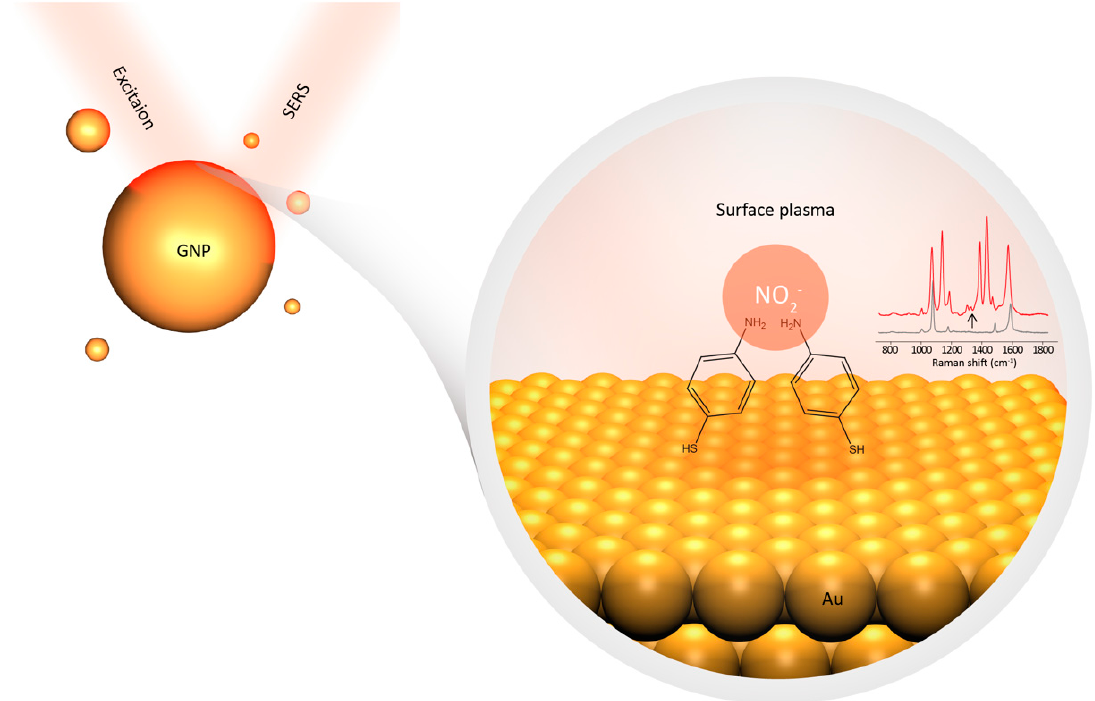
Figure 1. Schematic illustration of the sensing principle. NO 2 − trigged surface plasmon-assisted conversion of PATP to DMAB on GNPs, resulting in a change in the SERS spectra of GNP.